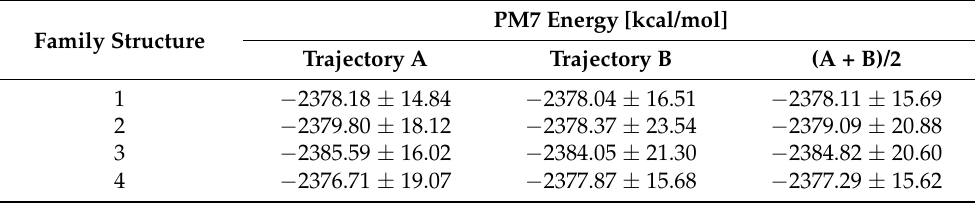
Table 7. PM7 semi-empirical results of calculations for compound 1 /DNA binary